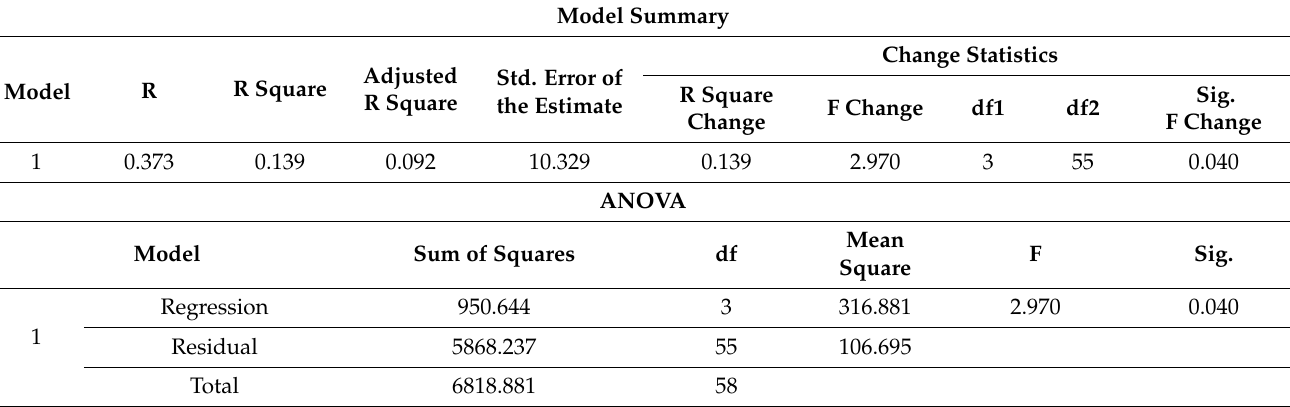
Table 4. Results of regression analysis of variables of recording tools, synchronous communications, and sharing information on the quality of teacher instruction.